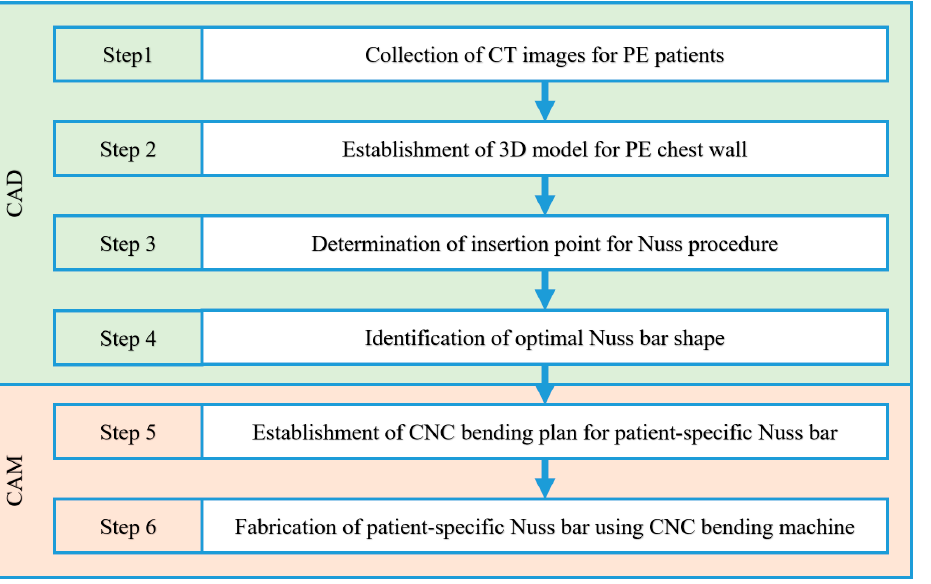
Figure 1. Fabrication procedure for the patient-specific Nuss bar.